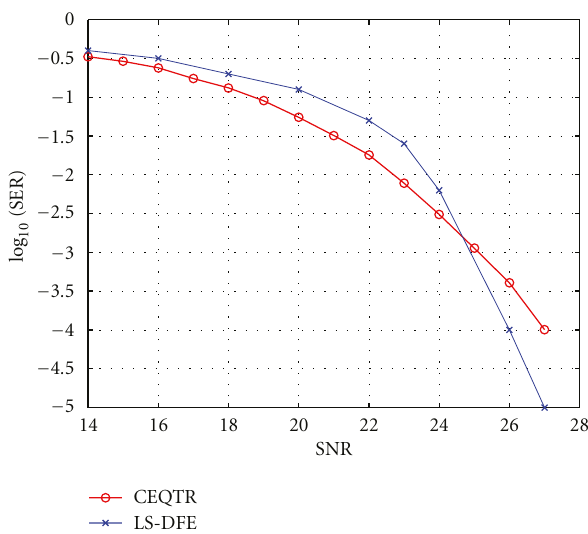
Figure 9: CEQTR, and LS-DFE Comparison, L = 768, MaxNTap = 176, α max = 16, FIR init @ B L/ 2 = 1 . 0, η CMA = 10 − 4 and η DD = 10 η CMA